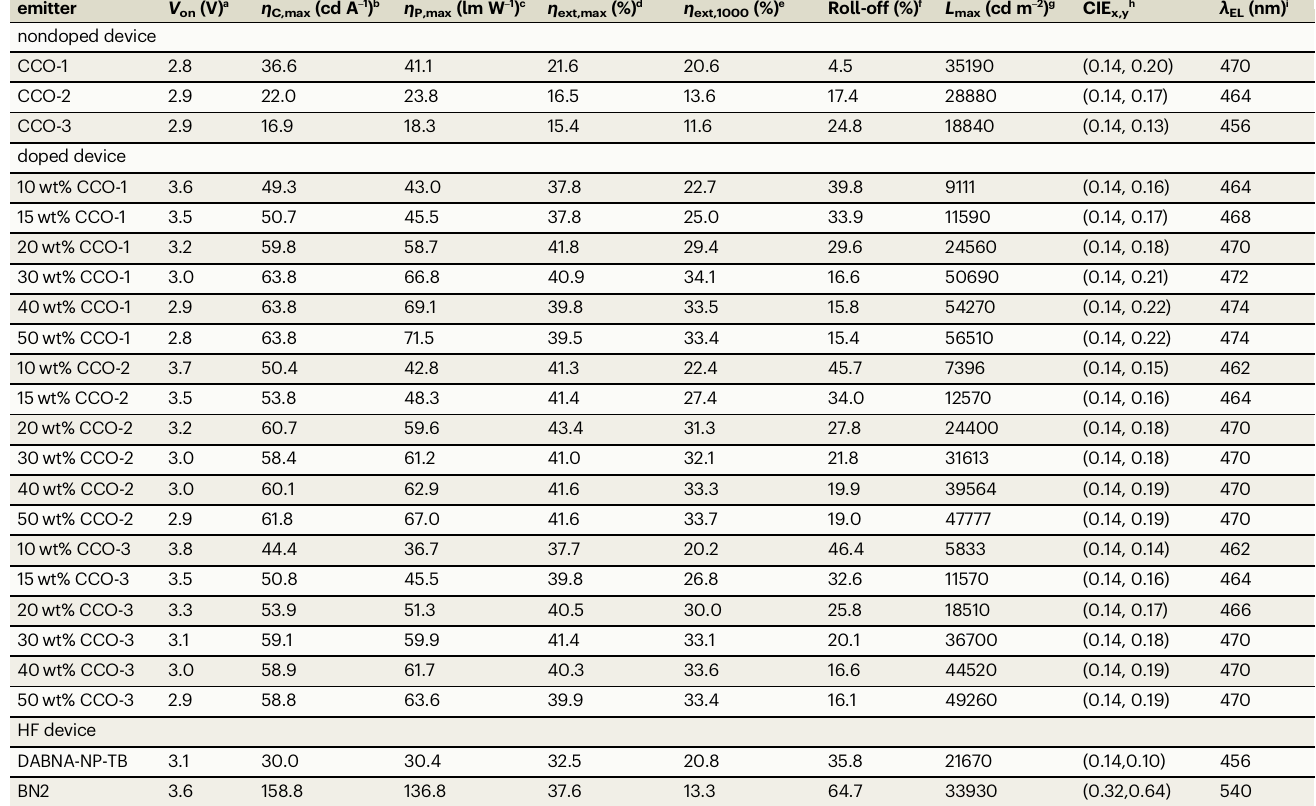
Table 2 | EL performances of the new molecules in nondoped, doped and HF OLEDs emitter V on (V)